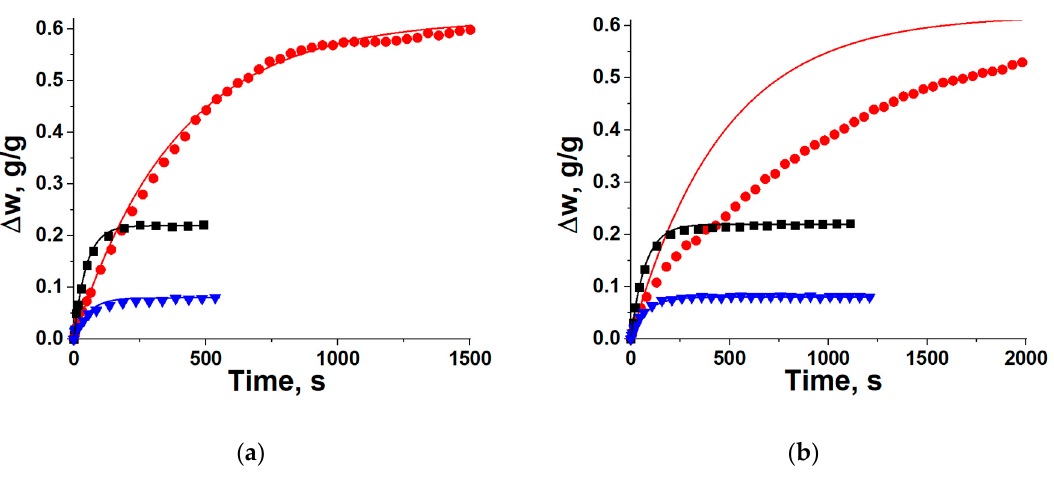
Figure 5. Methanol uptake ( a ) and release ( b ) curves for Maxsorb III S(P1)400 ( ■ ), ACM-35.4 ( ▼ ), and LiCl/MWCNT ( ● ). Solid lines—exponential approximation (3).